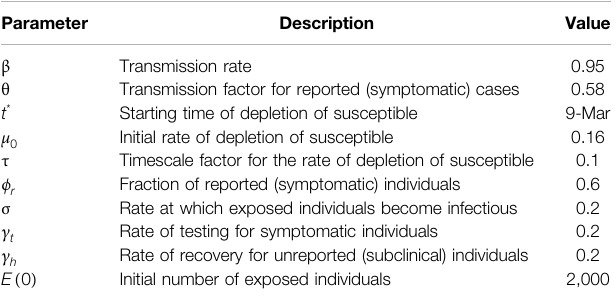
TABLE 1 | Optimal values of the estimated model parameters for the simulation of the outbreak in